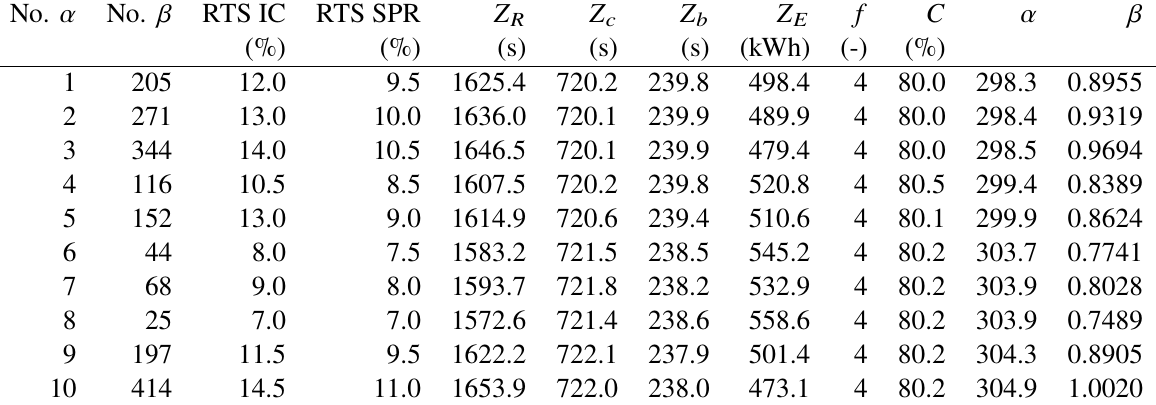
Table 3: First 10 Pareto-optimal solutions with 30 s minimum buffer time considering the objec- tives total running time 𝑍 , extended cycle time 𝑍 , buffer time 𝑍 and energy consumption 𝑍 𝑅 𝑐 𝑏 𝐸 for the real-world case Ah-Nm using the weighted sum method (sorted from low to high accord- ing to 𝛼